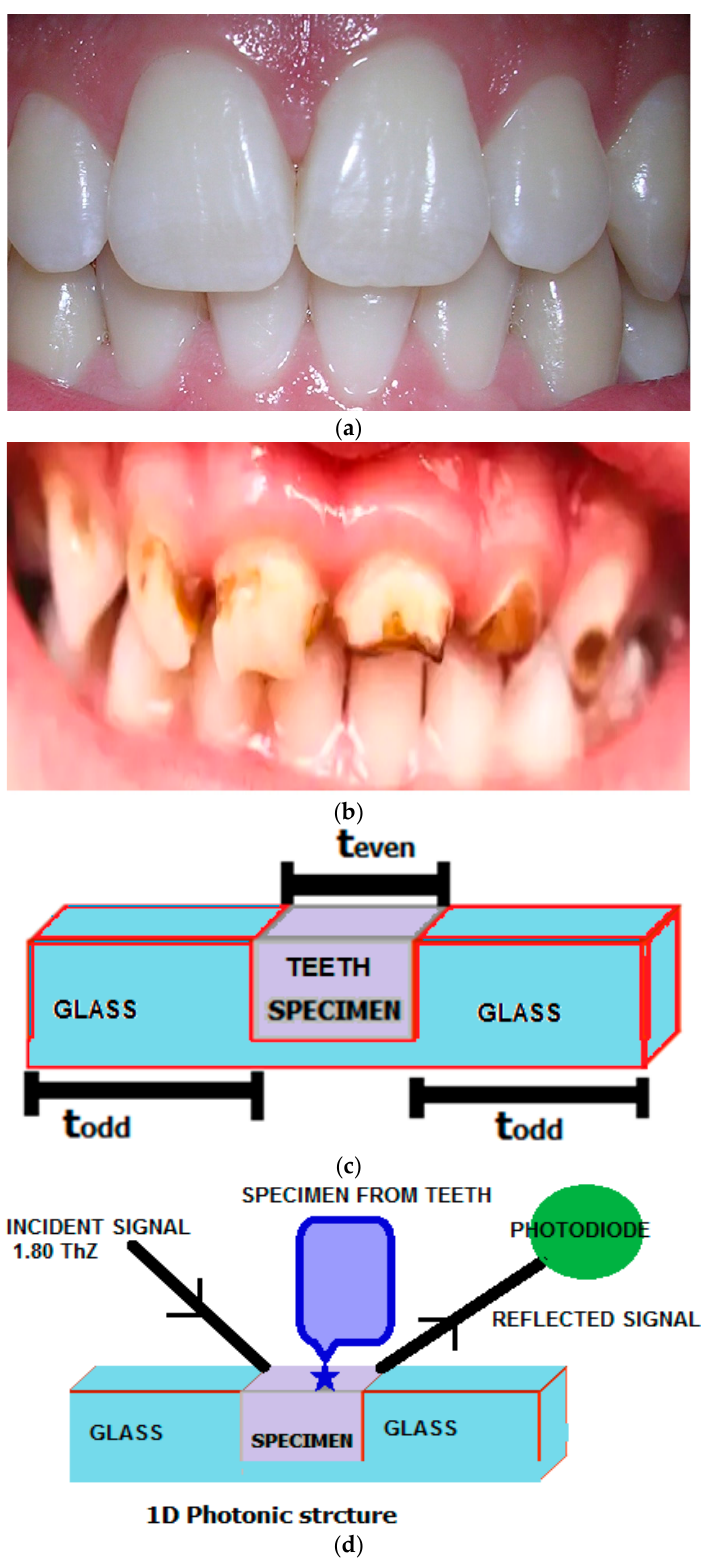
Figure 1. ( a ) Picture of normal teeth (no caries); ( b ) picture of abnormal teeth (caries); ( c ) one-dimensional photonic crystal structure to measure the specimen; and ( d ) the experimental setup to measure the deformation.